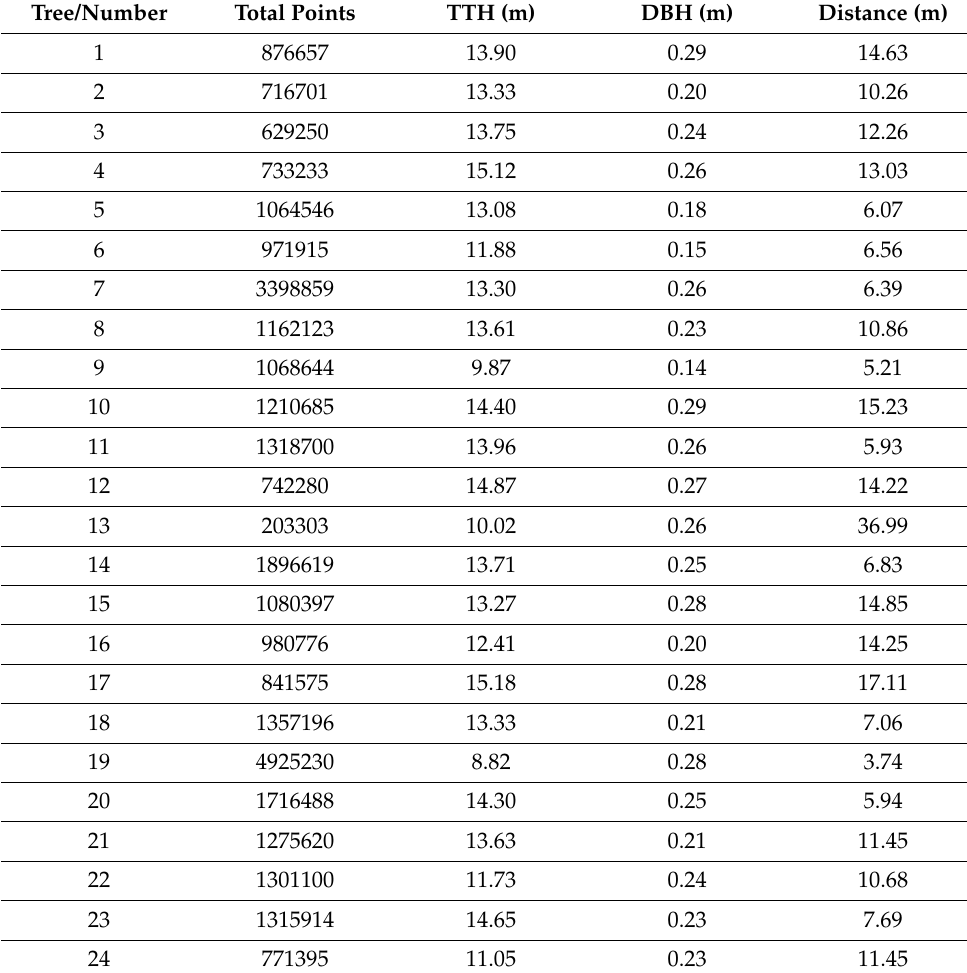
Table 2. The comprehensive information of 24